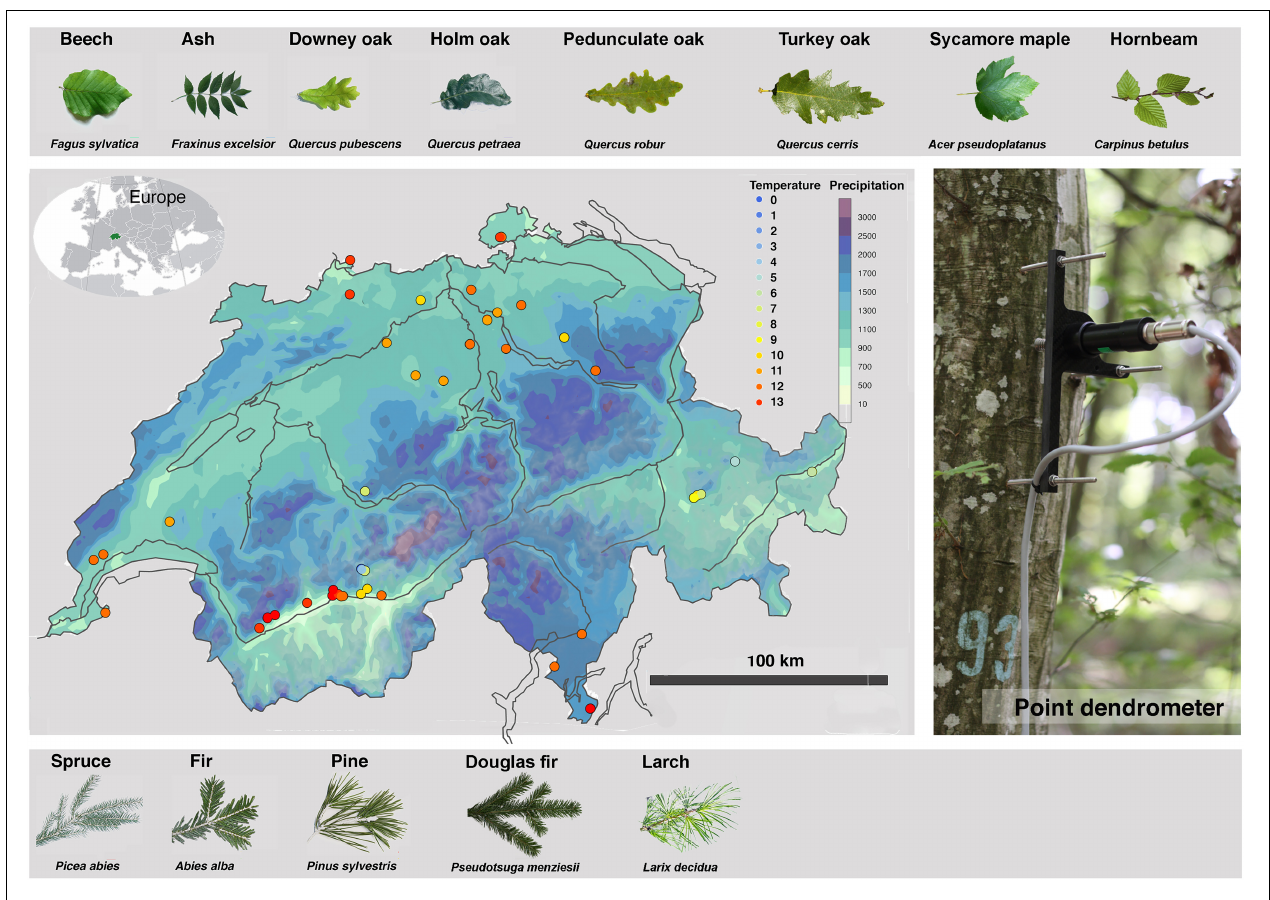
FIGURE 1 | Locations of the 61 TreeNet sites in Switzerland (www.treenet.info) including thirteen tree species of about 420 individually measured trees. Sites are defined as forest patches with a specific species composition and specific environmental conditions. The background color of the map indicates the average annual precipitation. The site dots are color-coded according to the mean annual temperature. Sites cover gradients of mean annual temperature between 0 and 13 ◦ C and annual precipitation sum from 600 to 1,800 mm, respectively. The photo shows a point dendrometer mounted on a beech tree. Find further site details in the Supplementary Material ( Supplementary Table 1 ). The background color of the map indicates the average annual precipitation